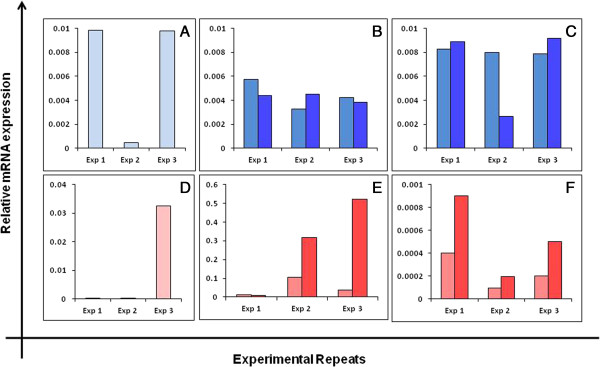
Relative mRNA expression (Y-axis) by qRT-PCR for Fsh-r1 and Fsh-r3 transcripts. Upper panel shows R1 transcript of FSH receptor mRNA expression in (A) initial scraped OSE and after (B) 3 hrs and (C) 15 hrs with (dark blue bars) and without (light blue bars) FSH treatment. Please note that R1 transcript levels are not affected much by FSH treatment. Lower panel shows R3 transcript of FSH receptor mRNA expression in (D) initial scraped OSE and after (E) 3 hrs (F) and 15 hrs with (red bars) and without (pink bars) FSH treatment. Note the increased expression (more than ten-fold) of R3 transcript after FSH treatment at 3 hrs followed by a reduction to basal levels at 15 hrs (please note a change in Y-axis scale to appreciate a difference between D-F). The relative expression levels of each transcript from three different experiments are represented individually (see Results section for more details).